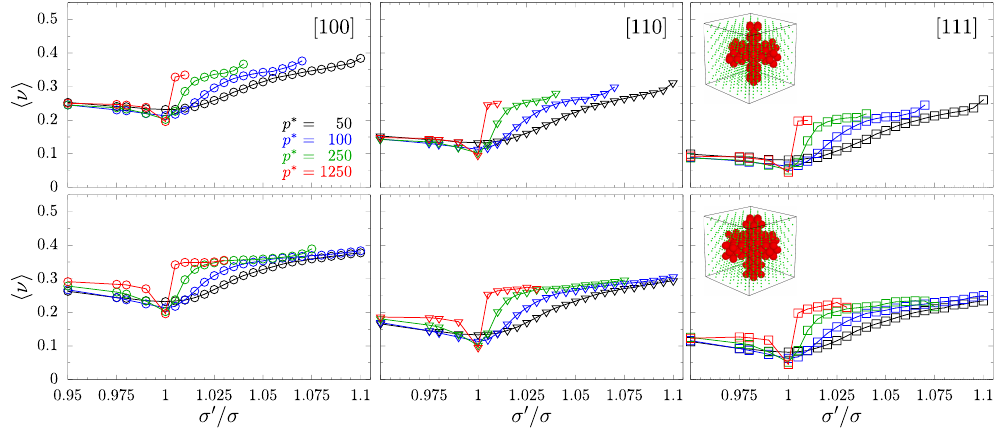
Figure 7. PR for selected (cid:126) n -directions, indicated in the top right of their respective columns, averaged over all possible (cid:126) m -directions. Different symbols (circles, triangles, and squares) correspond to PR in the directions [ 100 ] , [ 110 ] , and [ 111 ] , respectively. The figure contains data for models with crossing nanochannels. Plots for the respective size of the nanochannel have been arranged in rows, as indicated by the miniature structure inserts. The values of the reduced external pressure p ∗ have been indicated in colors.